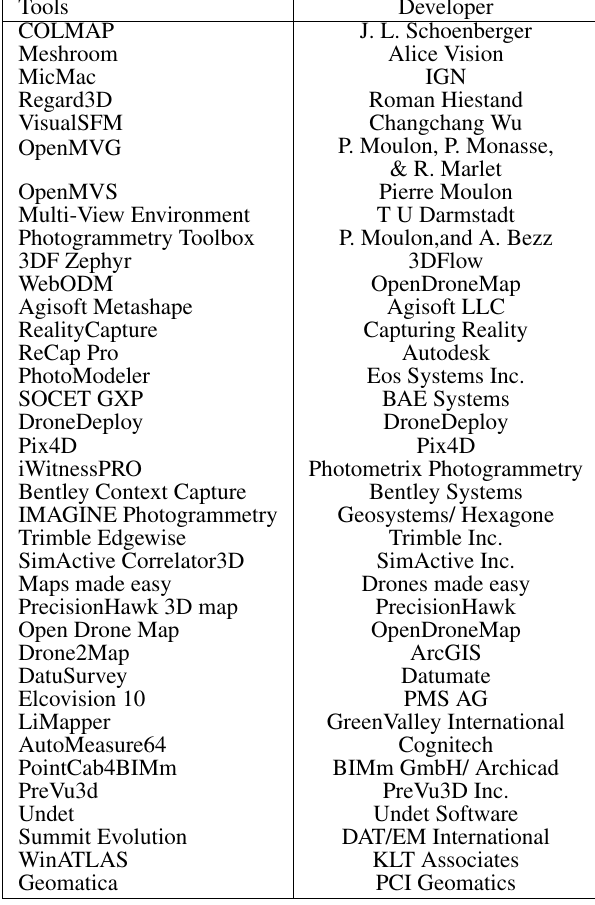
Table 1. List of available photogrammetry tools.